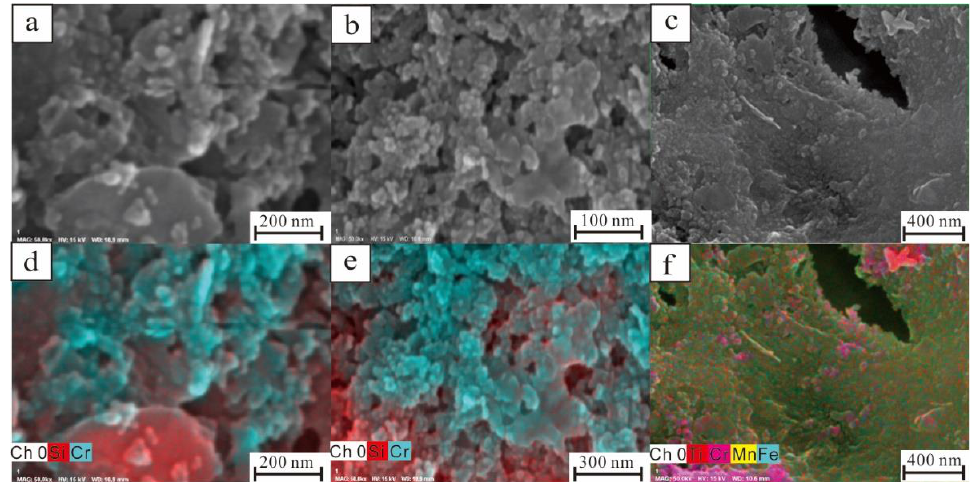
Figure 9. Nanomineral particles in polymetallic nodules. ( a ) Nanomineral particles in region 2; ( b ) nanomineral particles in region 3; ( c ) nanomineral particles in the shell; ( d – f ) corresponding distributions of Cr, Si, Mn, and Fe elements.